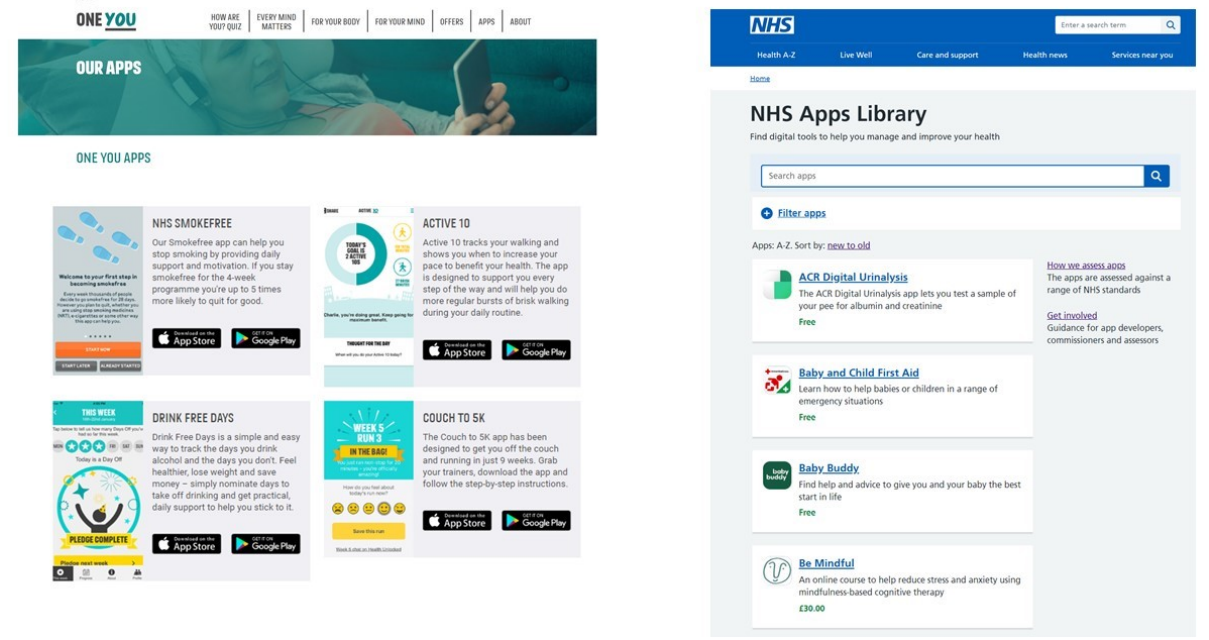
Figure 2. Screenshot of the Public Health England’s ‘One You Apps’portal and the ‘NHS Apps